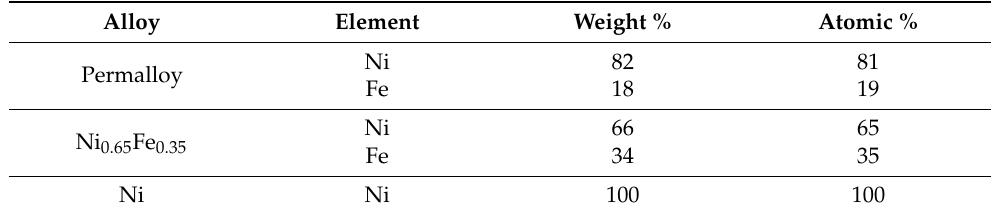
Table 1. Elemental composition of NiFe alloy films electroplated by potentiostatic deposition. Alloy